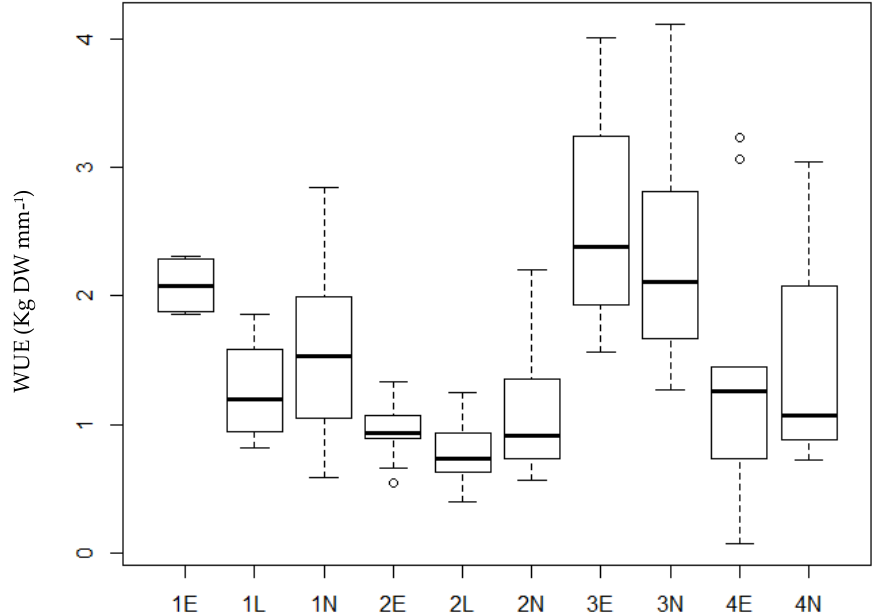
Figure 6. Pearl millet mean yields (a) and water use efficiency (WUE) (b) during different planting windows during cropping seasons (SES1 Early (1E) N = 32, Normal (1N) N = 24, Late (1L) N = 12; SES2 Early (2E) N = 36, Normal (2N) N = 88, Late (2L) N = 24; SES3 (3E) Early N = 16, Normal (3N) N = 164; SES4 Early (4E) N = 156, Normal (4N) N = 24).